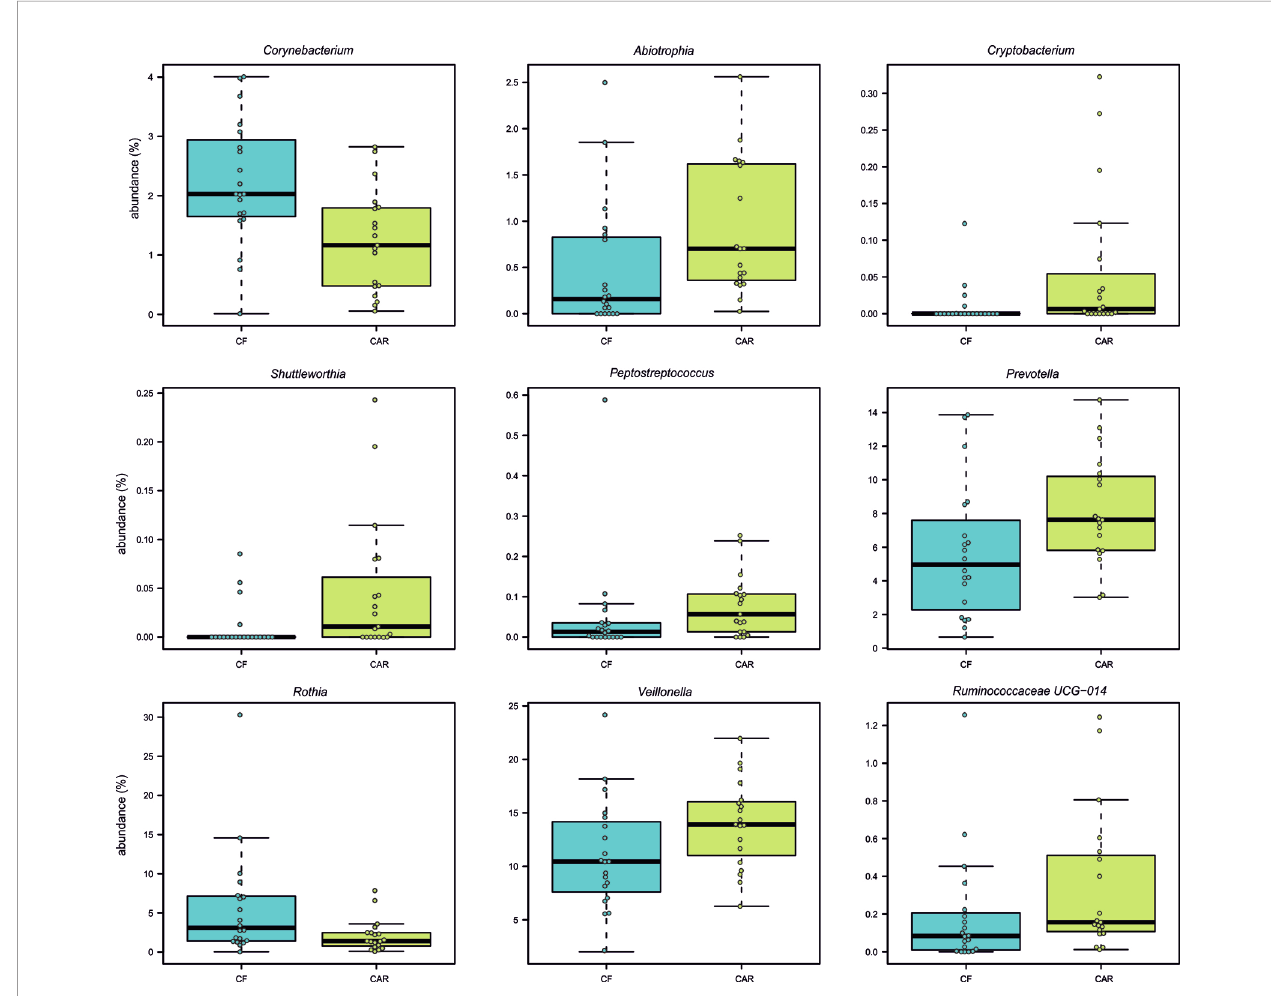
FIGURE 3 | Bacterial genera with statistically signi fi cant differences in abundance between caries-free (CF) and caries-experienced (CAR) adolescents. Individual samples are represented as circles. All p-values (Wilcox test) are lower than